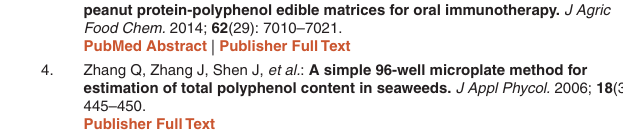
Table S1: Replicate measurements of green tea extract for total phenolic content. SD: standard deviation. Click here to access the data.